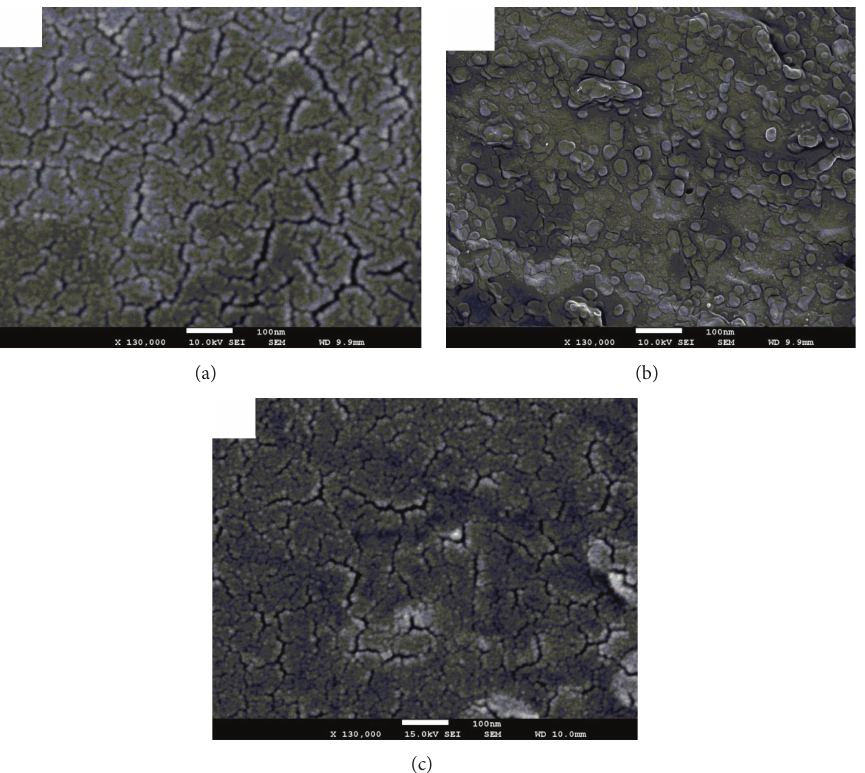
Figure 6: SEM images of the surface of (a) virgin PVDF, (b) PVDF- g -PVTri, and (c) PVDF- g -PVTri-(TA) 3 membranes at 100 nm scale level by 130,000x magnification, respectively.